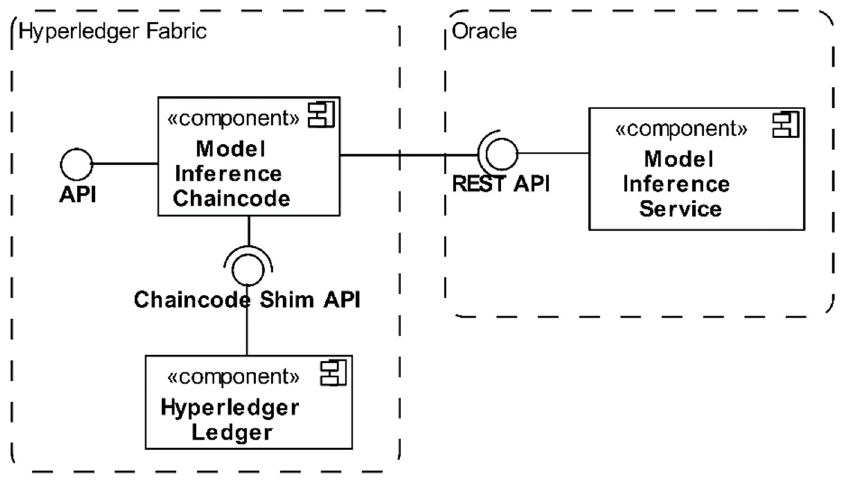
Figure 1. The utilized blockchain architecture: Unified modelling language (UML) component diagram. Chaincode Shim API provides access to data stored in the chaincode state database.